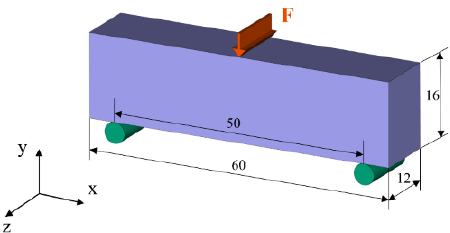
Figure 5. The boundary conditions of the MBB beam.